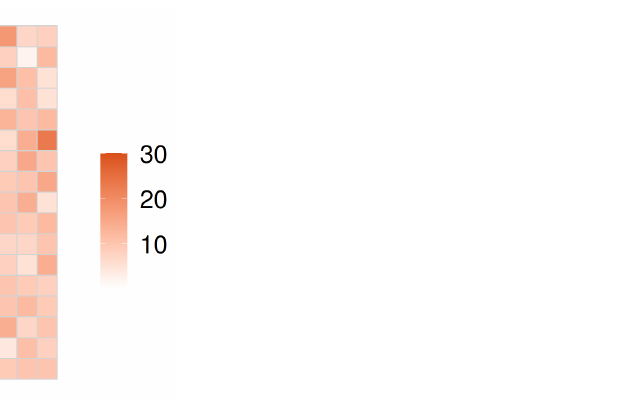
Figure 2. Spatial distribution of the simulated data. Each subregion is colored according to the number of point event occurrences.